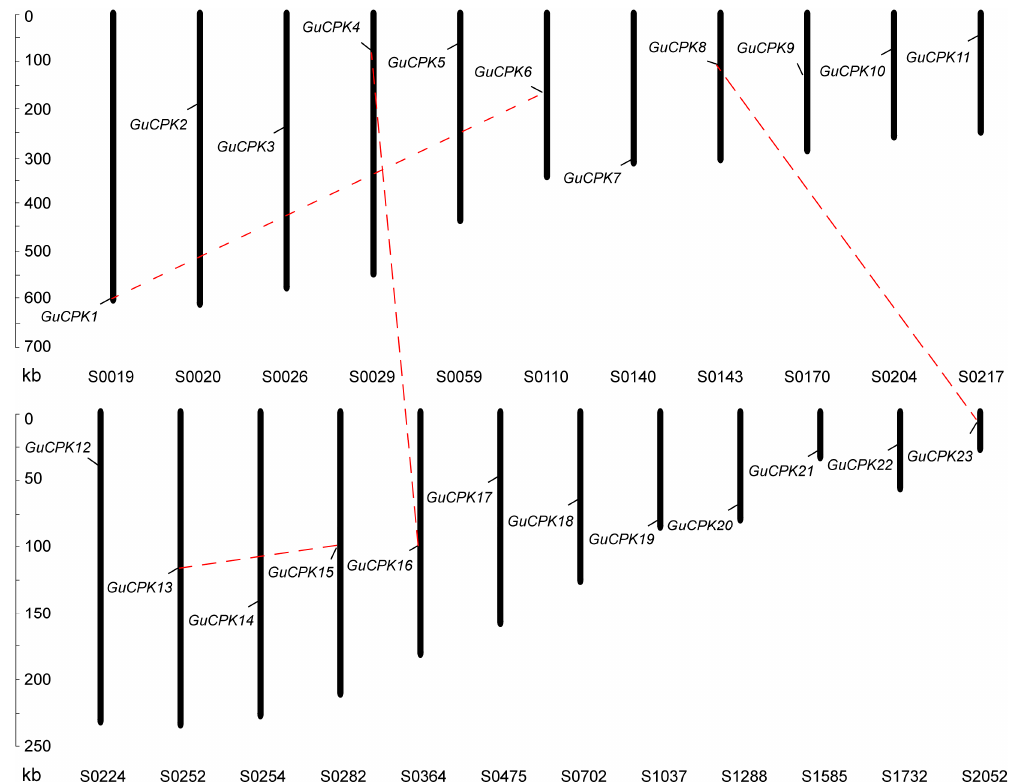
Figure 2. Scaffold distribution of GuCPKs in G. uralensis . GuCPK genes are located on 23 individual scaffolds. Vertical columns represent the scaffolds with scaffold numbers at the bottom and scale bars on the left. Pairs of segmentally duplicated genes are indicated by red dashed lines.